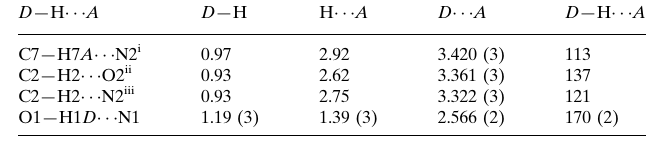
Hydrogen-bond geometry (A˚ , (cid:2)